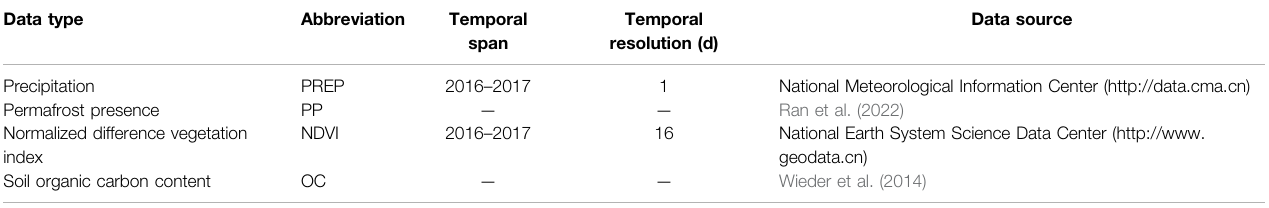
TABLE 1 | List of environmental controllers for aquatic DOC concentrations in the source area of the Yellow River (SAYR) above the Tanag hydrological station in Qinghai Province, Southwest China. Data type